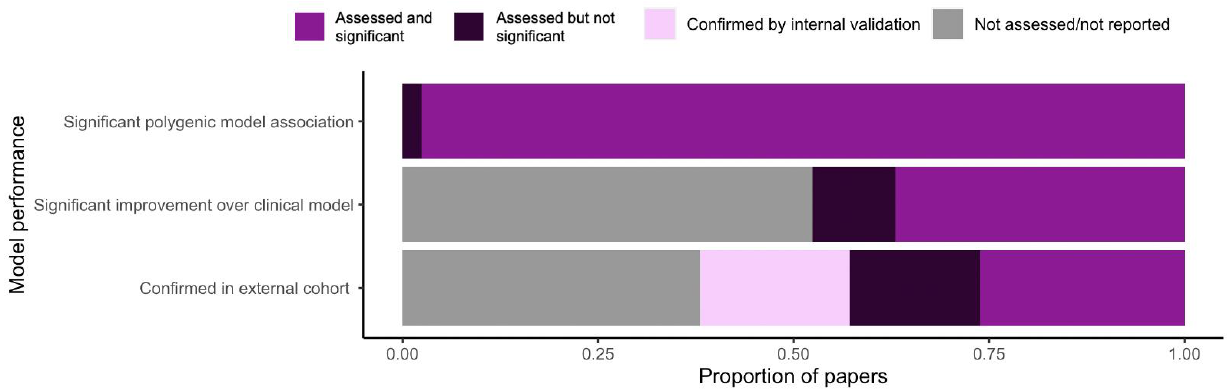
Figure 3. Summary of performance and validation of polygenic models for predicting drug out- comes.